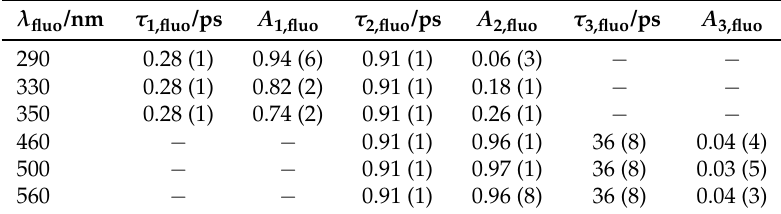
Table A1. Decay times τ i and relative amplitudes A i from the analysis of the fluorescence up-conversion